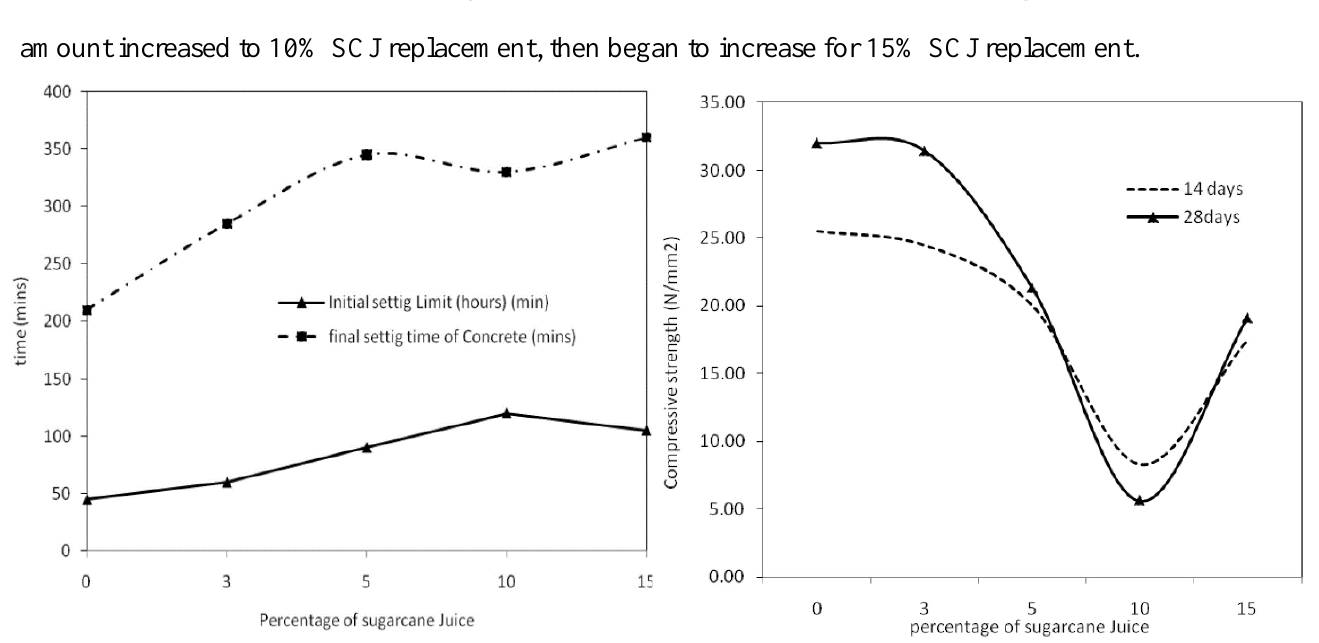
Figure 9. Test results sugar cane juice affects concrete properties (Otunyo and Koate) Otunyo et al. [16] investigated the effect of sugar cane juice on concrete properties such as setting time, workability, bulk density, and compressive strength. The study found that partial water